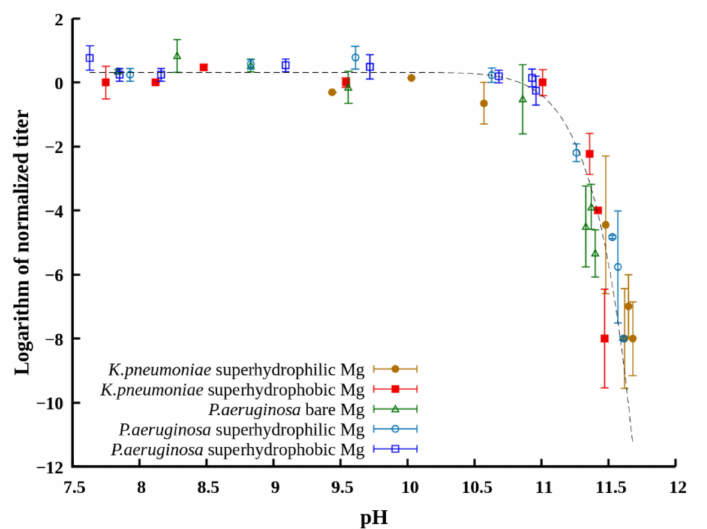
Figure 8. The dependence of the bacterial titer in the bacterial dispersion contacted for different times with the magnesium substrate on the pH of the dispersion medium. In the legend, bacteria names denote the dispersion of the corresponding bacterial strain in PBS. The dashed line bearing a feature of the “master curve” is a least-square power-law fit. Error bars represent the standard